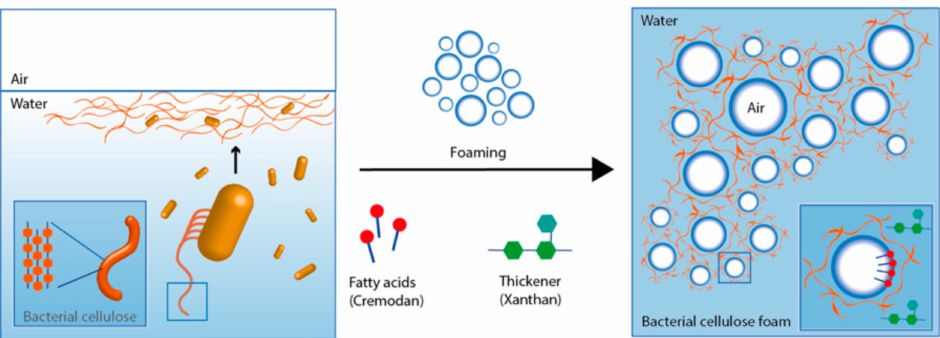
Figure 6. Schematic presentation of the BC foam formation process by K. xylinus suspension foaming and stabilization by Cremodan and xanthan as a thickener. Reproduced from [75], with permission from npj Biofilms and Microbiomes,